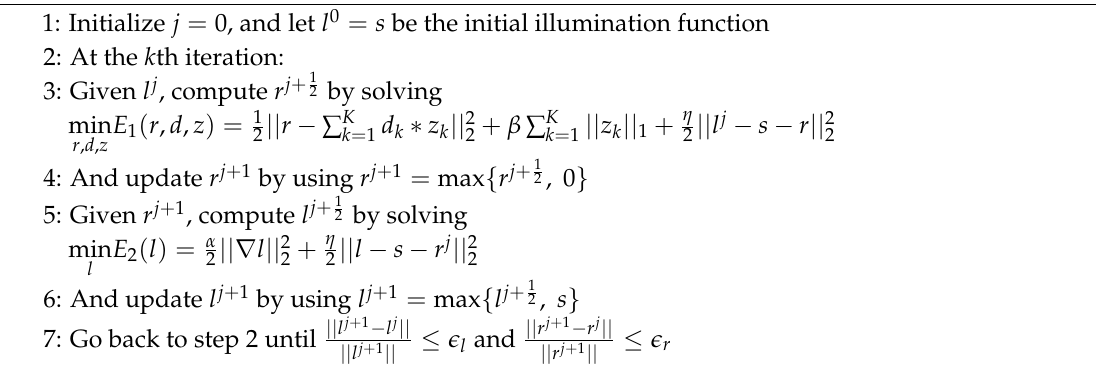
Algorithm 1: Basic Pseudo-Code for Proposed CSC Retinex